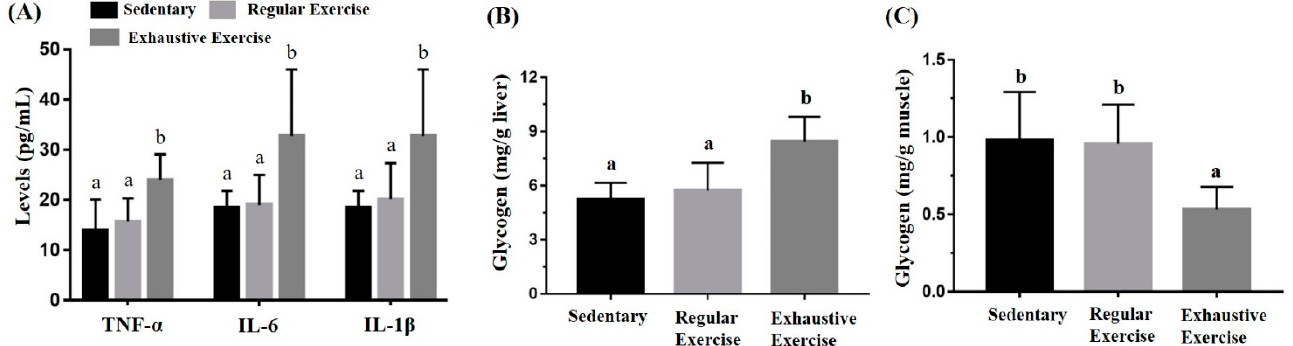
Figure 6. Effects of the eight-week training intervention on plasma cytokine expressions ( A ), liver glycogen ( B ), and muscle glycogen ( C ). The serum and tissue samples were collected at the end of the study for cytokine and glycogen analyses. Data are represented as mean ± standard deviation, and the columns with different letters (a, b) represent a significant difference between groups ( p < 0.05) by using one-way ANOVA.